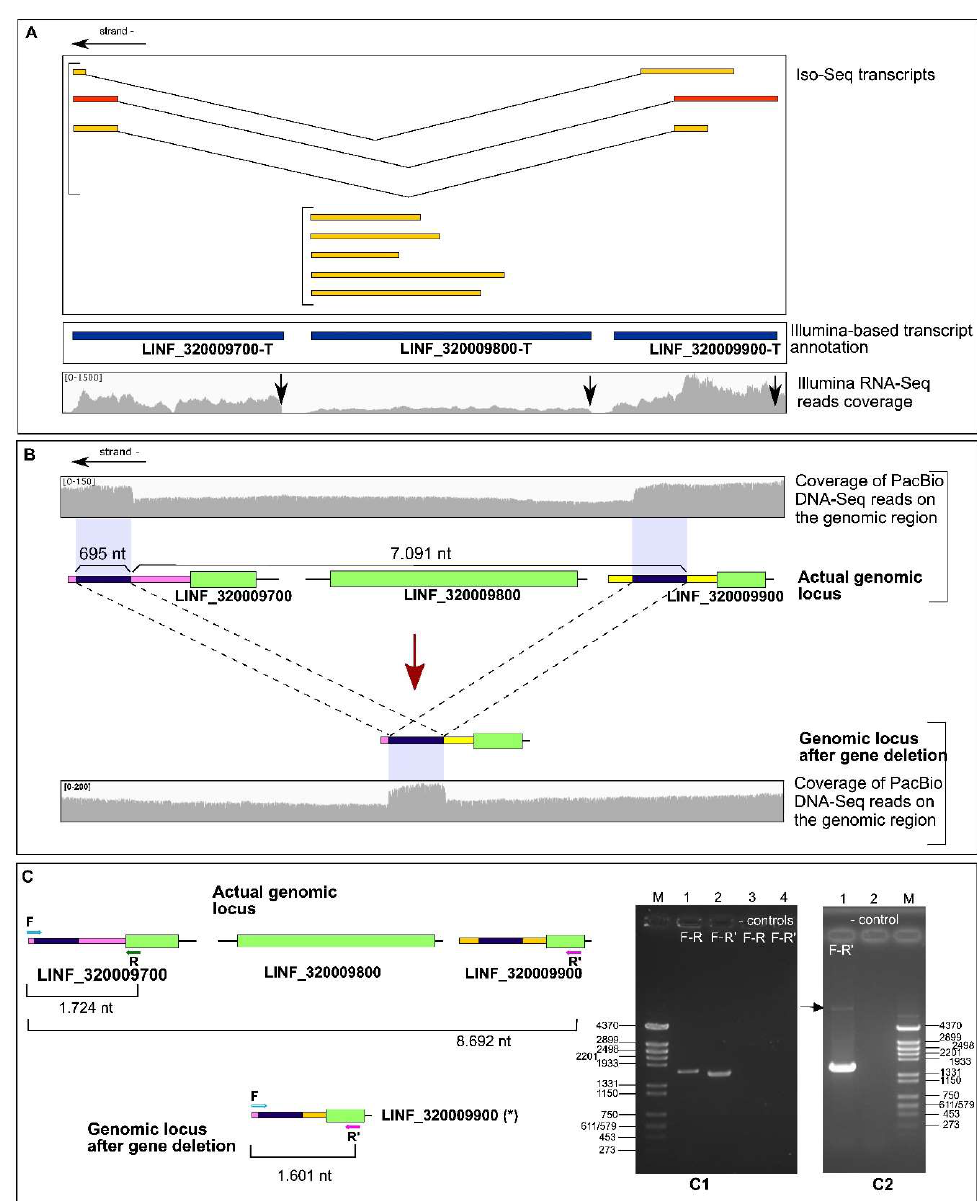
Figure 2. Allelic heterogeneity on a genomic region of L. infantum chromosome 32. ( A ) Two types of transcripts (Iso-Seq molecules) were identified: one derived from gene LINF_320009800 and the other showing a chimeric nature (derived from separated genomic regions). ( B ) The existence of a lower number of PacBio DNA-seq reads in the region-expanding genes LINF_320009700 , and LINF_320009800 suggested an intrachromosomal deletion event affecting one allele. The hypothesized structure for both alleles is depicted together with the PacBio DNA-seq reads coverage on both regions. The existence of a direct repeat of 695 nt in length is denoted by black boxes. ( C ) Experimental testing by PCR of the deletion event. Two pairs of oligonucleotides (F-R and F-R’) were used to amplify the 3′-UTR of gene LINF_320009700 and the whole genomic region (genes LINF_320009700 , LINF_320009800 and LINF_320009900 ), respectively. The PCR products were separated on a 1% agarose gel (panel C1). A band of around 8.7 kb was also observed after PCR amplification with oligonucleotides F and R’ (panel C2). At the boundaries of gels are shown the sizes (in nucleotides) of the Hin dIII-digested Ø29 phage DNA bands used as a molecular marker (M). Lanes 3 (gel C1) and 2 (gel C2) are controls in which PCR was performed in the absence of a DNA template.